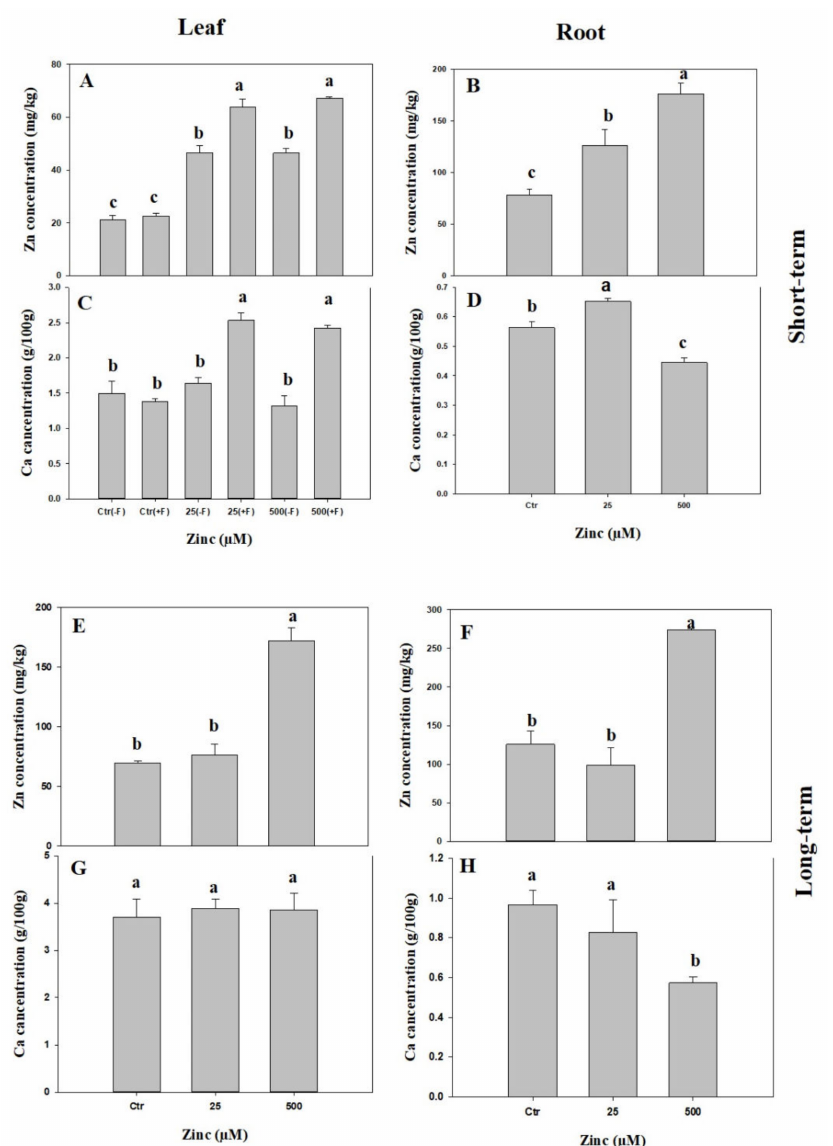
Figure 4. E ff ect of zinc concentration (0, 25 and 500 µ M) on Zn and Ca concentrations of pak choi plants. After short-term application: ( A ) Zn concentration in leaf, ( B ) Zn concentration in root, ( C ) Ca concentration in leaf, ( D ) Ca concentration in root, where –F represents the measurements in the leaves that were not sprayed and + F represents the measurements in the leaves that were sprayed. After long-term application: ( E ) Zn concentration in leaf, ( F ) Zn concentration in root, ( G ) Ca concentration in leaf, ( H ) Ca concentration in root. Values are means ± SE ( n = 5). Bars with di ff erent letters represent significant ( p < 0.05) di ff erences after ANOVA and an LSD (Least significant di ff erence)